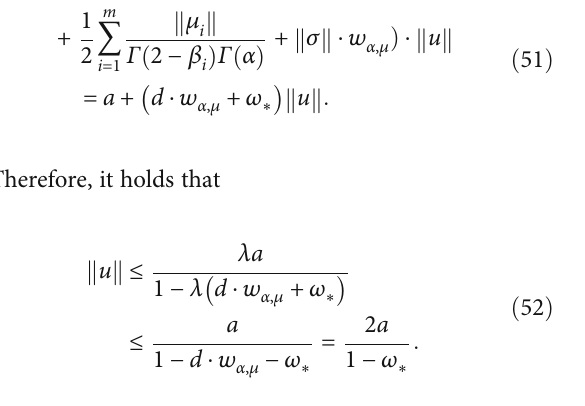
ffiffiffiffiffiffiffiffiffiffiffiffiffiffiffiffiffi p 1 + u 2 t ð Þ